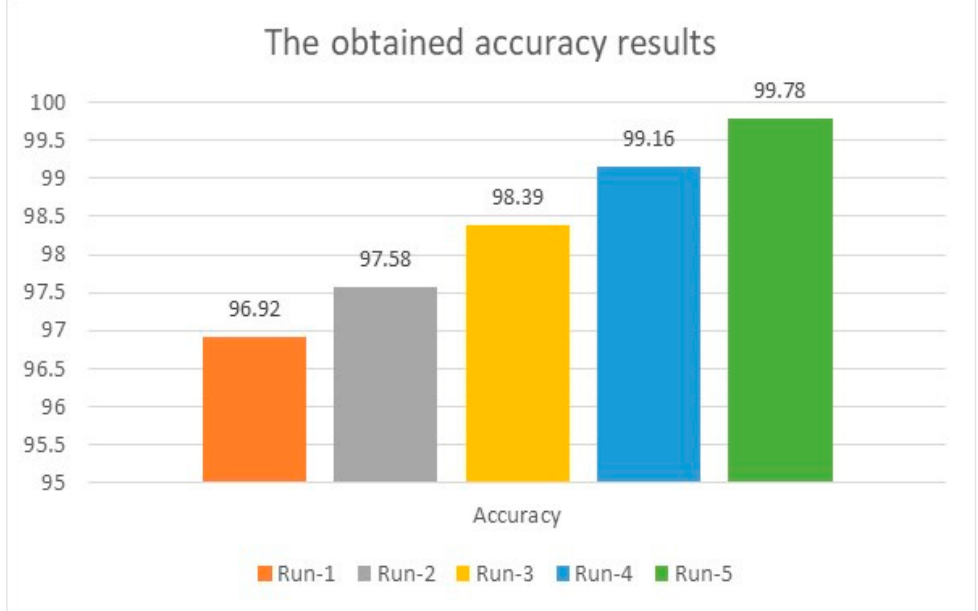
Figure 9. Accuracy analysis using customized LSTMs and ResNet50V2.